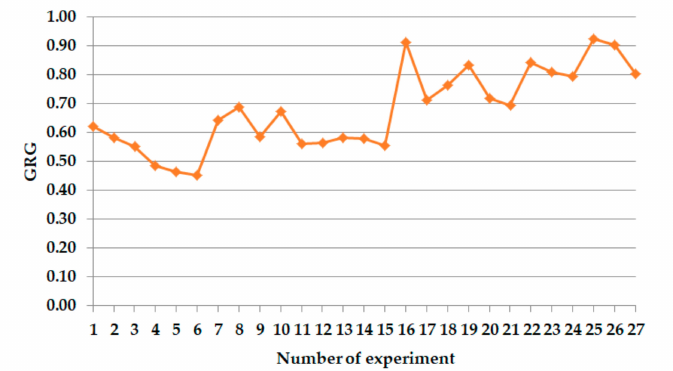
Figure 7. The grey relational grade (GRG) of the experiments.